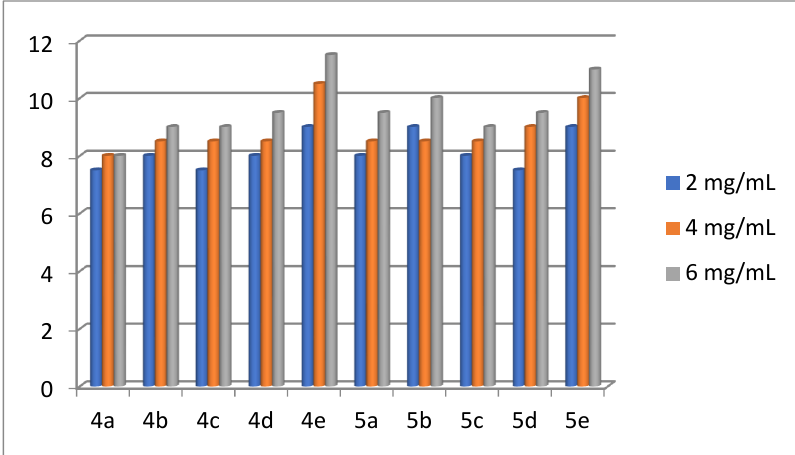
Figure 2. Graphical presentation of inhibition zone diameter (mm) against E. Coli .